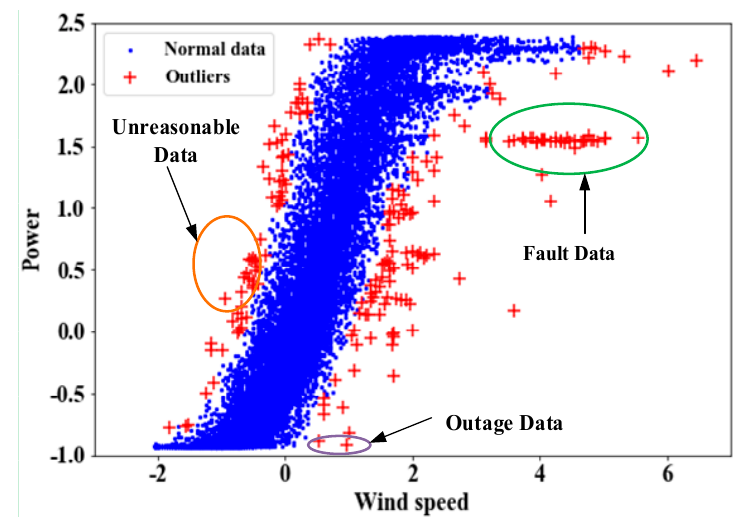
Figure 3. The scatter diagram of the wind speed and power after being identified.